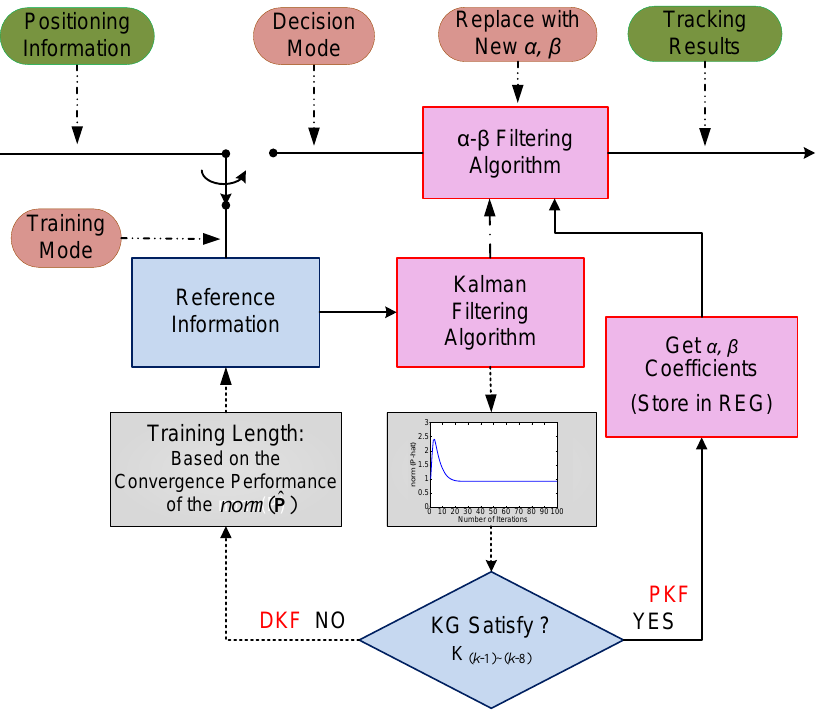
Figure 4. Flow diagram of the proposed approach.